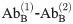
Tethering influenza antibodies increases breadth and potency.(A) The influenza A antibodies AbA1 and AbA2 were tethered together to form AbA1–AbA2 while (B) two influenza B antibodies formed AbB(1)-AbB(2). Representative data shown for an influenza A group 1 (blue), influenza A group 2 (green), and influenza B (gold) strains. Strong potency is marked by a small IC50 while large breadth implies that multiple strains are controlled by an antibody. (C) Representative states of HA and their corresponding Boltzmann weights for multidomain antibodies, where crosslinking between adjacent spikes boosts neutralization via avidity (ceff = 1400 nM in Eq (6)). (D) Theoretical predictions of the potency of all multidomain antibodies versus their measured values. The red points denote two outlier influenza strains discussed in the text that are not neutralized by AbA1 or AbA2 individually but are highly neutralized by their combination.